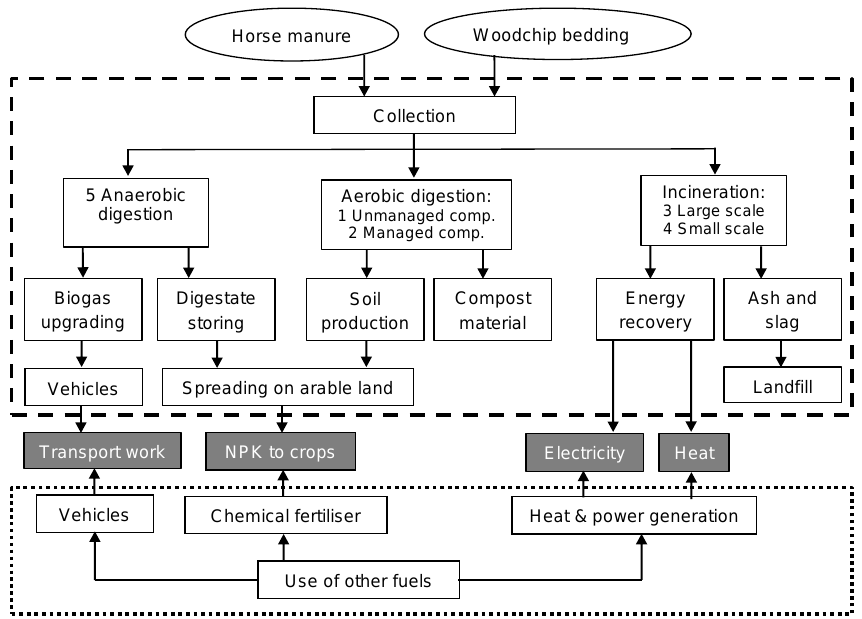
Figure 1. System under study. Numbering refers to scenario numbering.